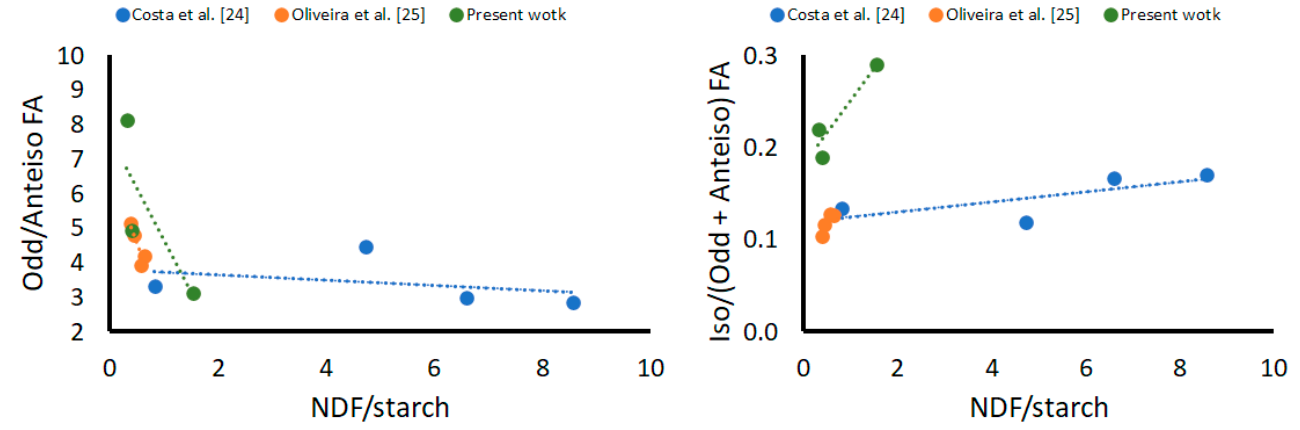
Figure 2. Responses of odd/anteiso and iso/(odd + anteiso) fatty acid (FA) ratios in the intramuscular fat of lambs to the neutral detergent (NDF) to starch ratio of the diet fed during the fattening period.